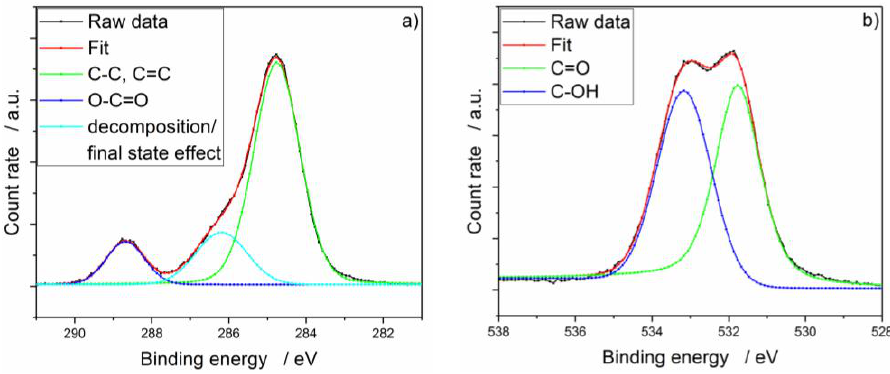
Figure 2. XPS detail spectra of polyester reference: ( a ) C1 s peak and ( b ) O1 s peak.